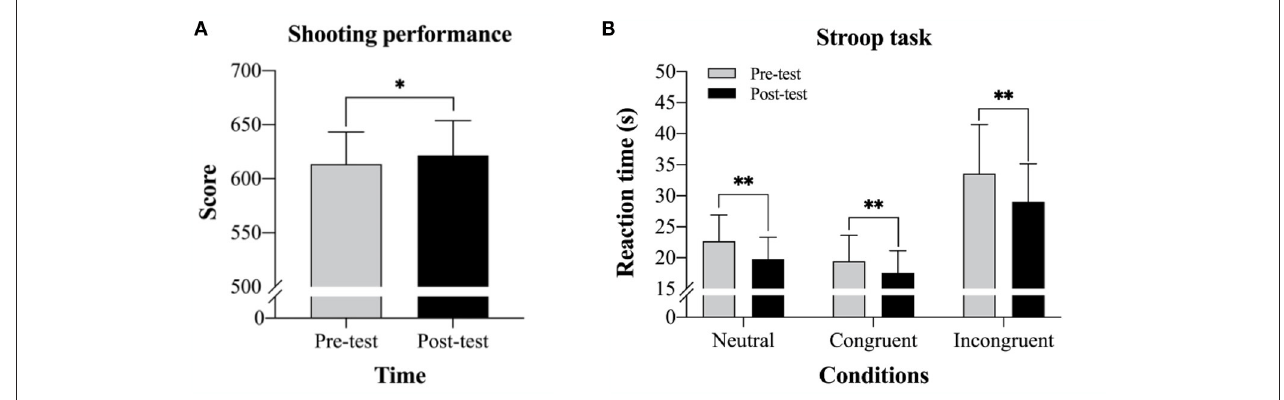
FIGURE 1 | Sport and cognitive function performance results in the pre-test and the post-test following the mindfulness-based peak performance (MBPP) program. (A) Comparison of shooting score ( M ± SE) results between the pre-test and post-test and (B) Comparison of Stroop task condition results between the pre-test and post-test. * p < 0.05, ** p <